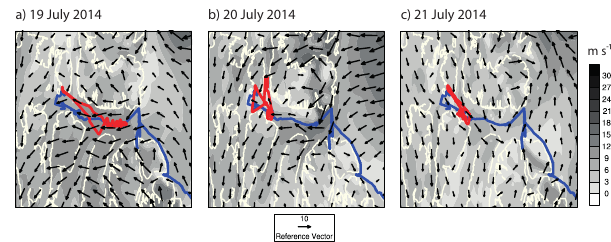
Figure 3. Snapshots of surface wind speed and direction predicted by WRF, with run details provided in Wentworth et al. (2016), dur- ing the Amundsen’s ship emissions measurements by the Polar 6 aircraft for plumes 1 (a) , 2 (b) , and 3 (c) . The shade of grey indi- cates surface wind speed and the arrow indicates both speed, with respect to the reference wind vector, and wind direction. The ship and aircraft tracks are indicated by red and blue traces, respectively.